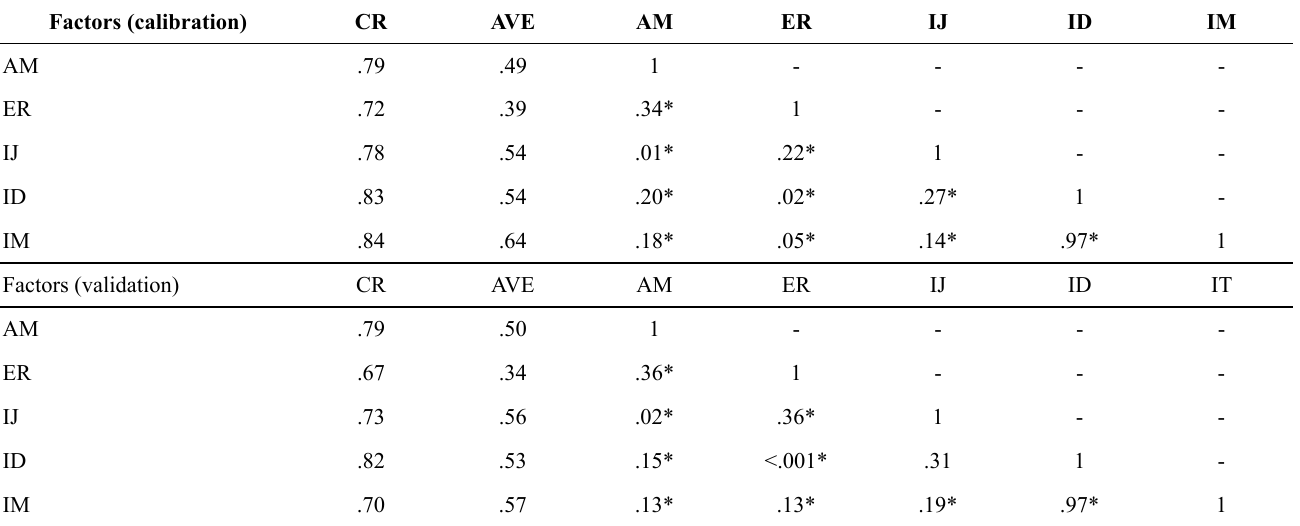
Table 3 Internal reliability, convergent and discriminant validity and average variance extracted – Calibration and Validation samples Factors